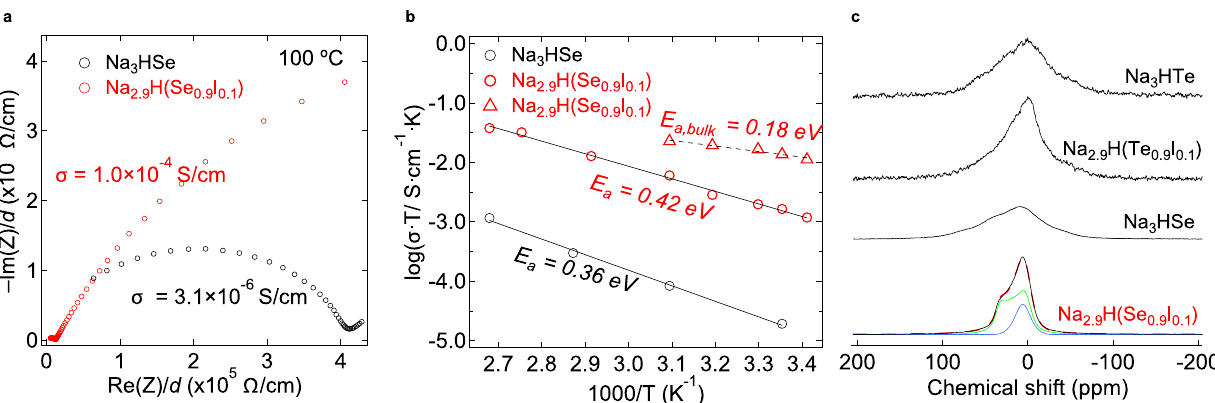
Fig. 6 Na + diffusion in Na 3 HSe and Na 2.9 H(Se 0.9 I 0.1 ). a Impedance plots at 100 °C of the cold-pressed pellets and the impedance is normalized to the respective pellet thickness. b Arrhenius plots of the total conductivity (circles) and bulk conductivity (triangles). c 23 Na static NMR spectra measured under 7 T at room temperature. For Na 2.9 H(Se 0.9 I 0.1 ), observed spectra (black solid), fi tting spectra (red dashed), and deconvolved peak 1 with C Q = 1.30 MHz, ŋ = 0.16 (green) and peak 2 with C Q = 1.33 MHz, ŋ = 0.03